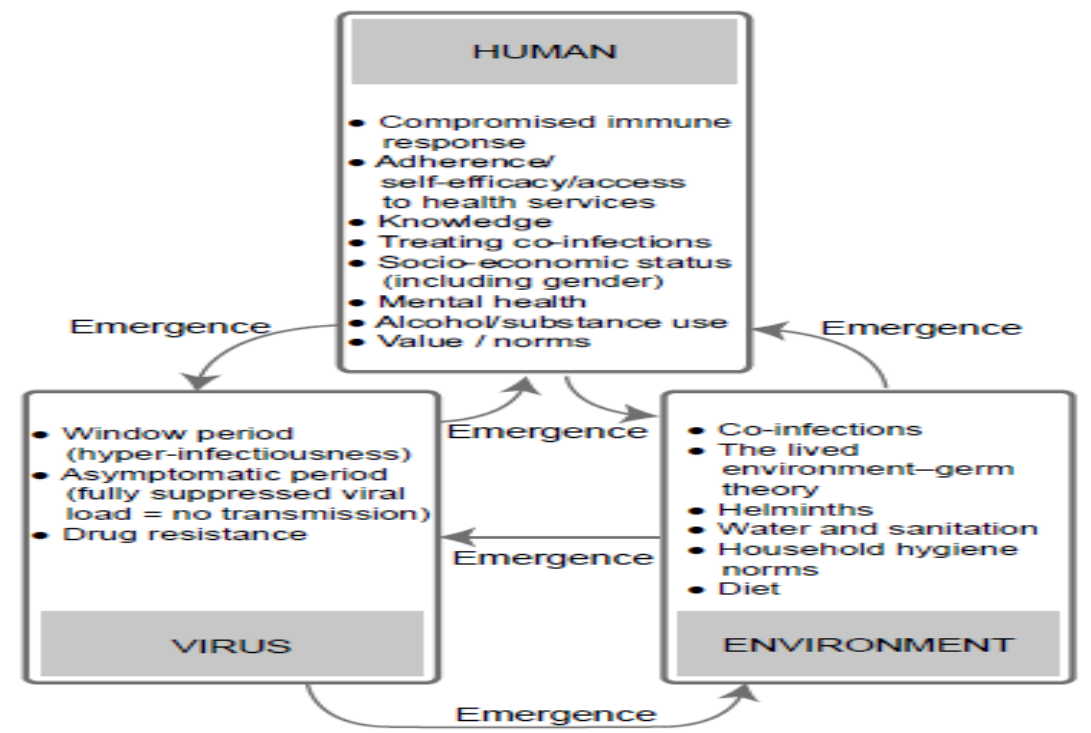
Figure 1. A generic representation of the interconnections that produce emergence within a complex adaptive HIV landscape. Source : Burman et al. (2015a, p.